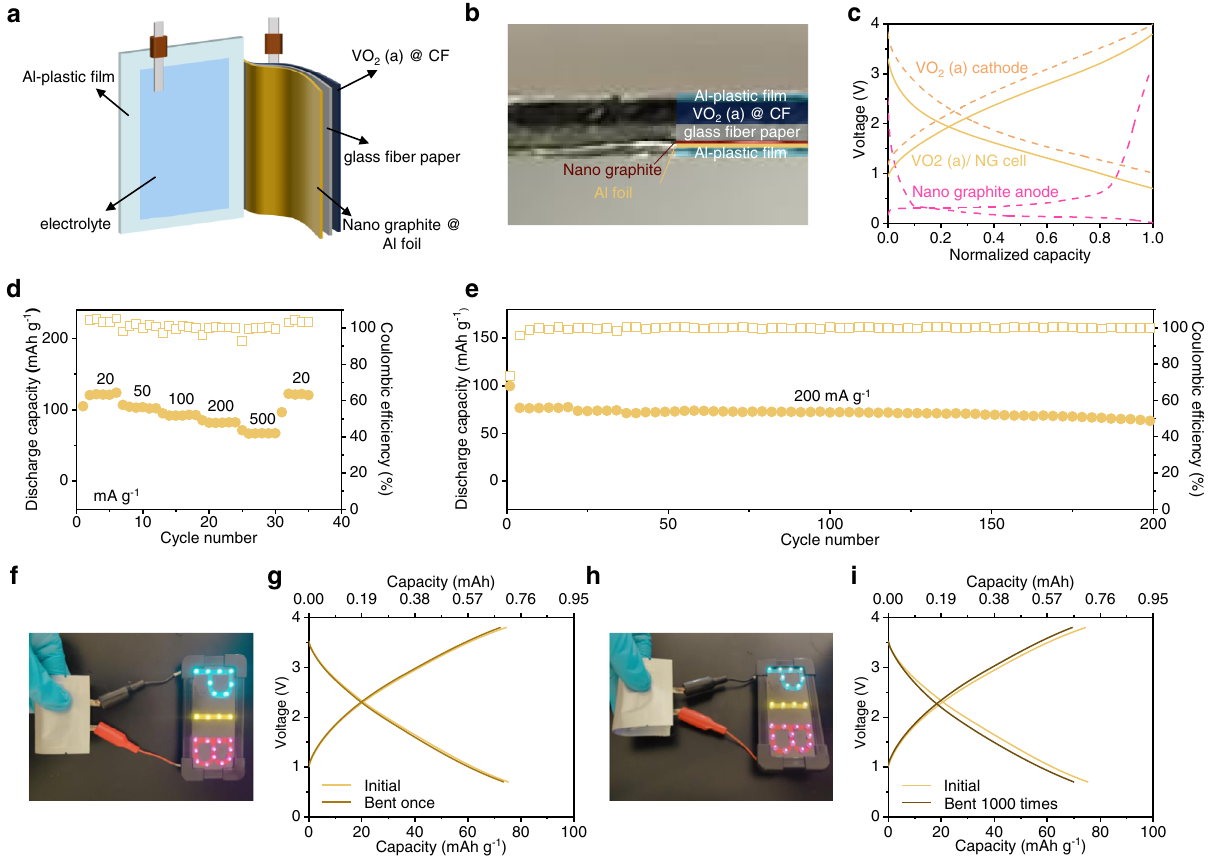
Fig. 6 | The electrochemical performance of the full battery. a Schematic dia- gram of the K ion full battery. b An optical photograph of the cross-section of the soft-pack battery. c Discharge/charge pro fi les of the half cells and the full battery. d Rate and ( e ) cycling performance at 200mAg − 1 for VO 2 (a)/nano-graphite in full